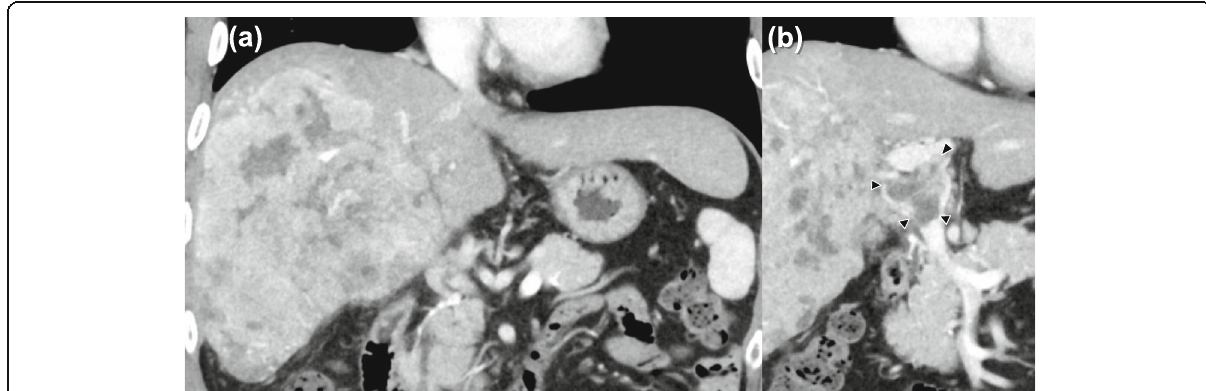
Fig. 1 CT findings before proton beam therapy. a A hepatic tumor with a diameter of 16.0 cm is observed in the right lobe. b The tumor is accompanied by portal vein tumor thrombosis in the main trunk (black